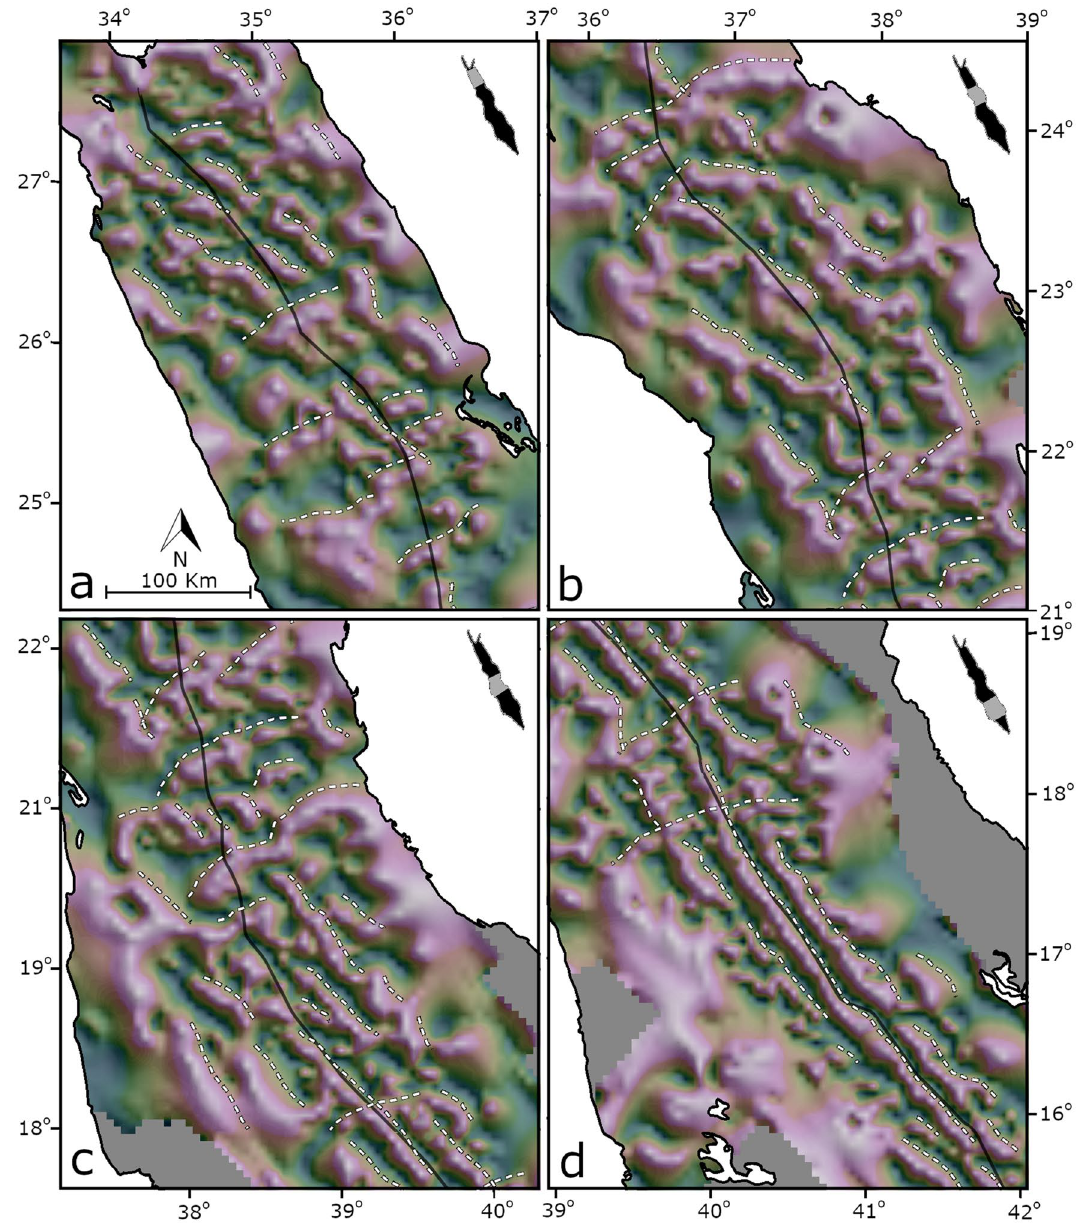
Figure 4. Tilt ‐ angle derivative map of magnetic anomalies, projected on a shaded relief. Purple colures represent positive angles and green colors represent negative angles. Black lines mark the Red Sea axis. White dashed lines highlight